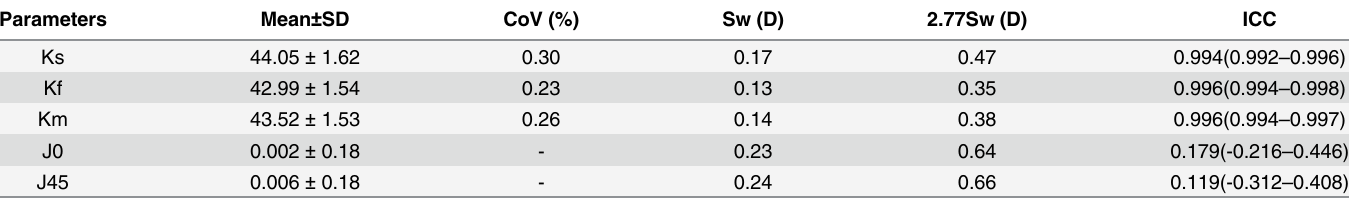
Table 5. The interobserver reproducibility of Ks, Kf, Km, J0 and J45 obtained by iTrace. (Note: D: diopter, SD: standard deviation, Sw: within-subject standard deviation, CoV: within-subject coefficient of variation, ICC: intraclass correlation coefficient.) Parameters